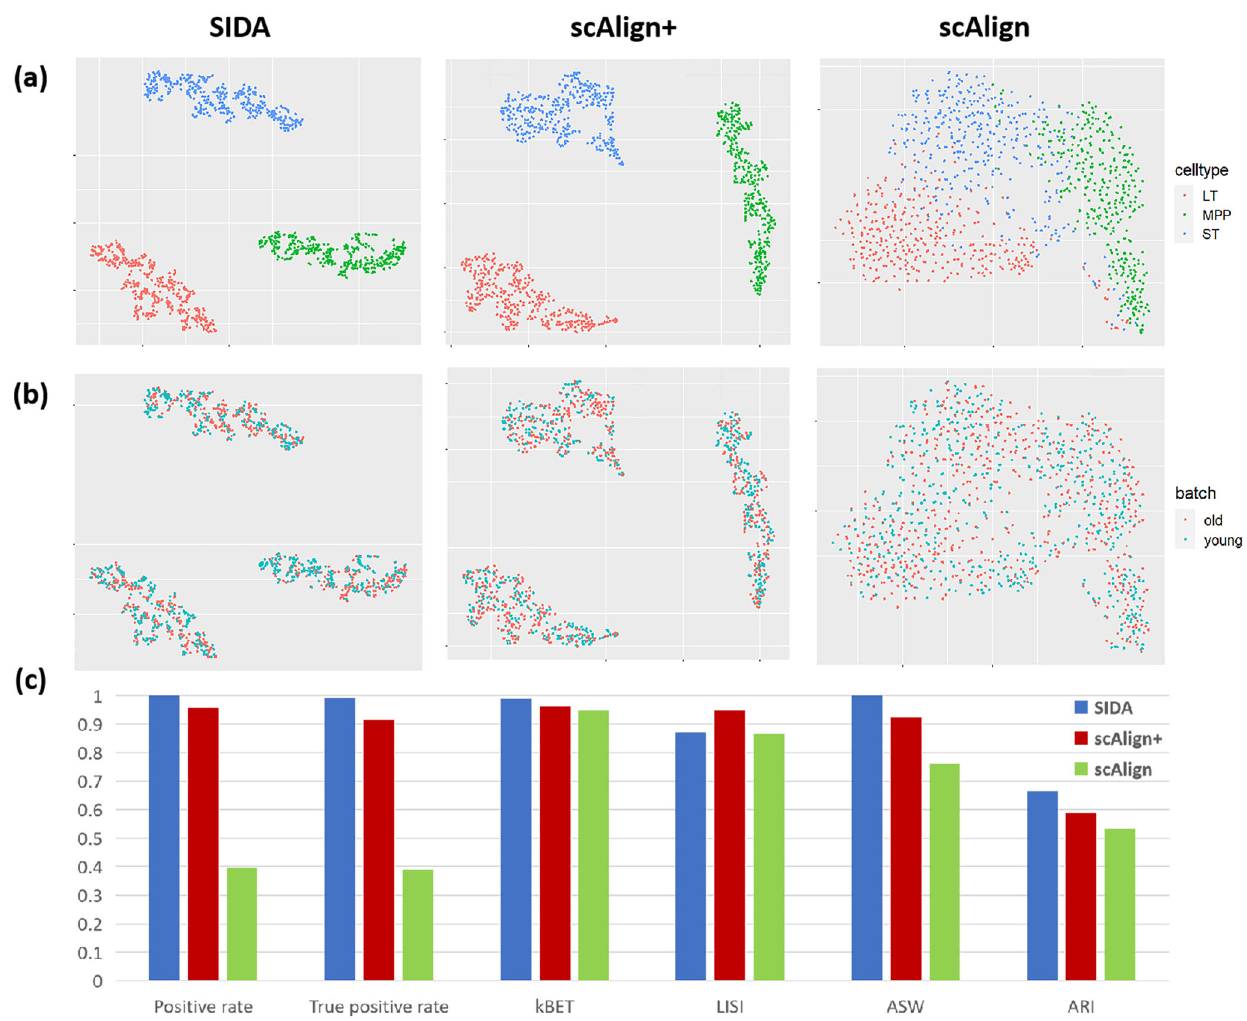
Fig. 4 Comparing SIDA, scAlign, and scAlign + on HSCs data collection. a tSNE visualization of SIDA, scAlign + , and scAlign colored by cell types; b tSNE visualization of SIDA, scAlign + , and scAlign colored by batch labels; c Evaluation metrics based on the HSCs data